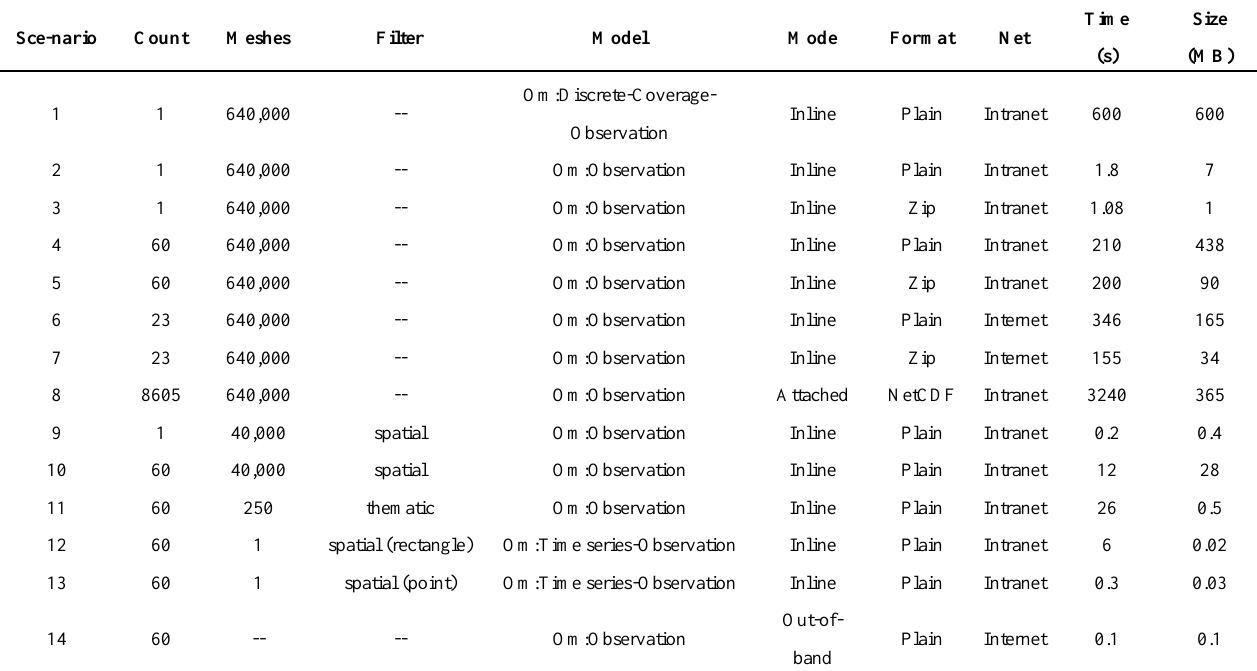
Table 2. Scenarios to analyze the response